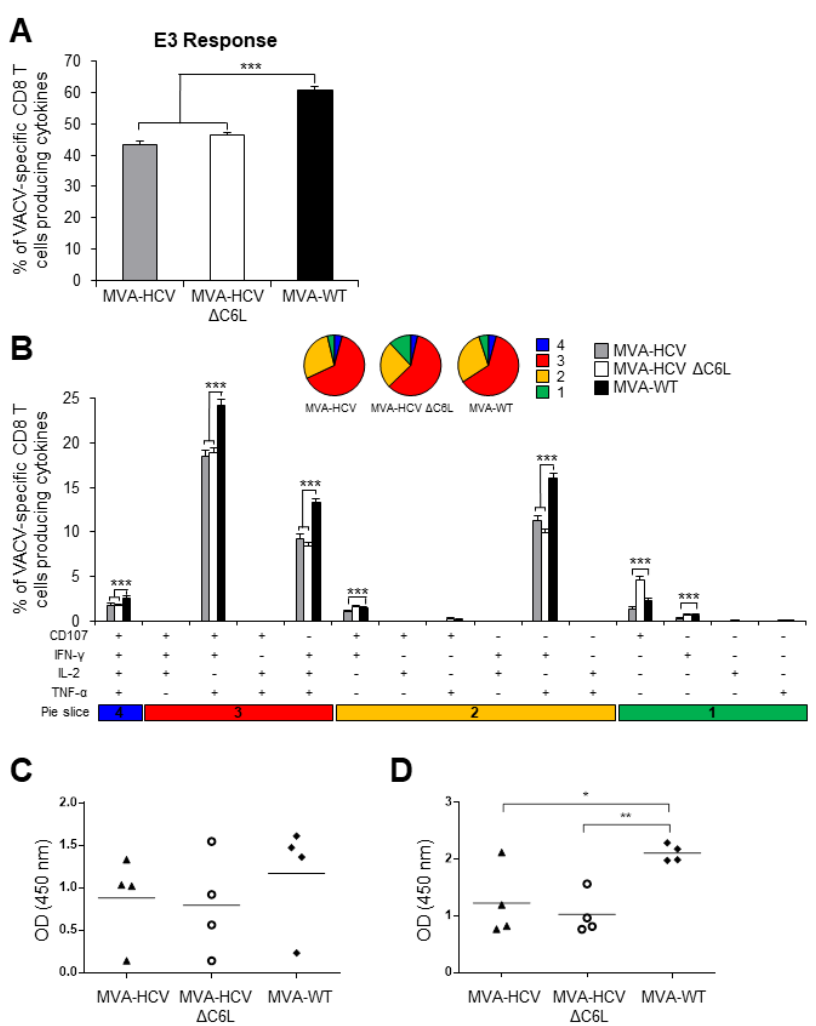
Figure 7. VACV-specific T cell and humoral immune responses induced in immunized mice. Splenocytes were obtained from mice ( n = 4 per group) immunized with two doses of